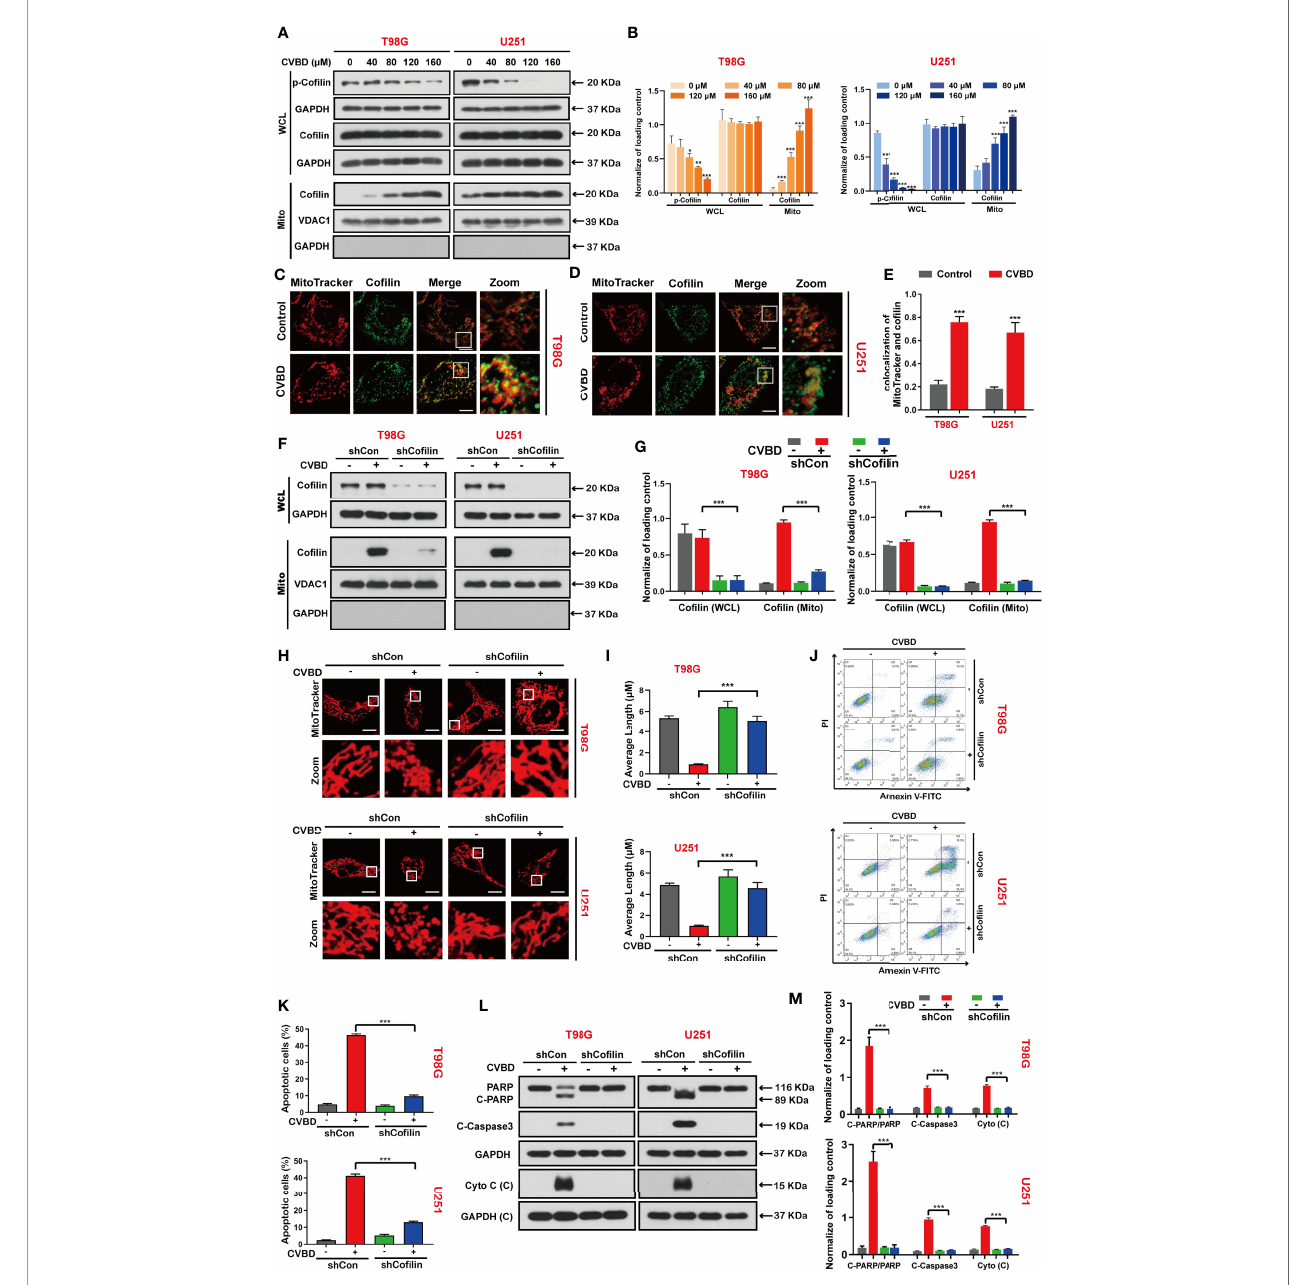
FIGURE 4 | CVBD induces mitochondrial translocation of co fi lin, and knockdown of co fi lin attenuates CVBD-mediated mitochondrial damage and apoptosis. (A, B) T98G and U251 cells were exposed to various concentrations of CVBD for 24 h. The expression level of p-co fi lin and co fi lin in the whole cell lysate (WCL) and co fi lin in the mitochondrial fractions was determined by Western blotting analysis. GAPDH and VDAC1 were used as loading controls. GAPDH was also used as cytosolic marker (mean ± SD of three independent experiments, *P < 0.05, **P < 0.01, ***P < 0.001 compared with the control group). (C, D) T98G and U251 were treated with CVBD (120 m M) for 24 h; the colocalization of MitoTracker (red) and co fi lin (green) was observed by confocal microscopy. Scale bars: 10 m M. For (E) Quantitative analysis of colocalization of MitoTracker (red) and co fi lin (green). Colocalization correlation coef fi cients were represented as mean ± SD (***P < 0.001 compared with the control group). For (F – M) , T98G and U251 cells were stably knocked down and exposed to CVBD (120 m M) for 24 h. (F, G) The expression level of co fi lin in the WCL and mitochondrial fractions was determined by Western blotting. GAPDH and VDAC1 were used as loading controls. GAPDH was also used as cytosolic marker. (H, I) The mitochondrial morphology was observed using MitoTracker (Deep Red FM) staining, followed by confocal microscopy. Scale bars: 10 m M. The mitochondrial average length was measured with Image J software. (J, K) Apoptosis was detected by Annexin V-FITC/PI staining and fl ow cytometry. (L, M) The expression level of PARP, C-PARP, C-Caspase3, and Cyto C (C) was determined by Western blotting analysis. GAPDH was used as a loading control (mean ± SD of three independent experiments, ***P <